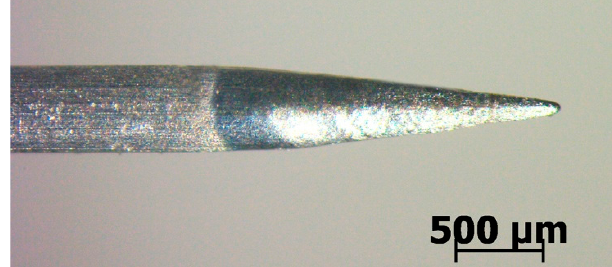
Figure 2. Tool electrode.